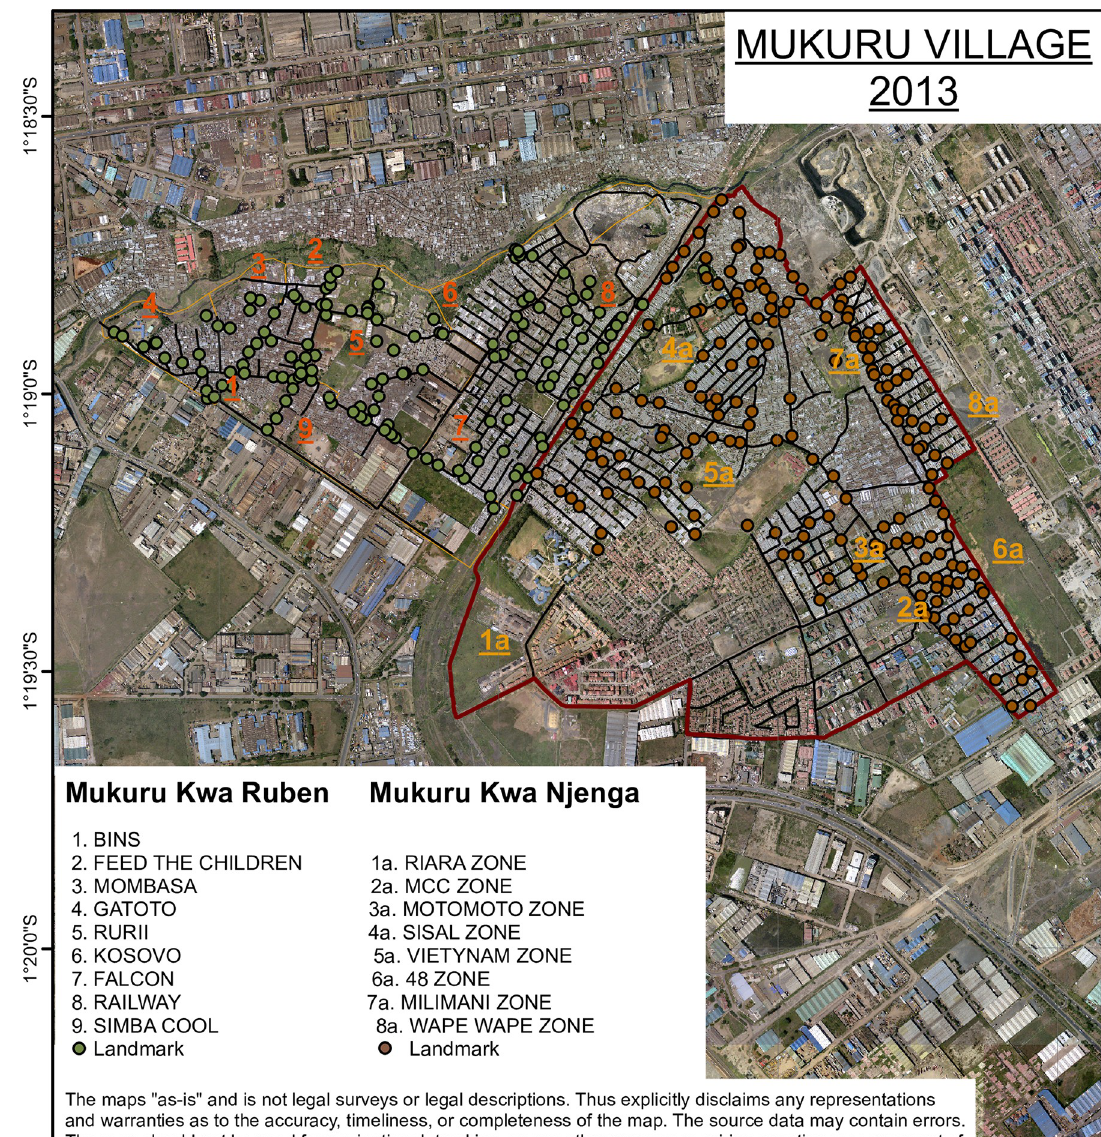
Fig 1. Mapped villages constituting Mukuru informal settlement study site. The image was acquired from Google Earth to create the map of structures/buildings of the study area as the first step of creating the GIS database. The images were geometrically rectified to a known coordinate system (Universal Transverse Mercator (UTM) 37S on the basis of a number of Ground Control Points (GCPs), selected from the periphery of the study area so that possible errors would converge towards middle of the area. Images were converted into TIFF files in ArcGIS10x